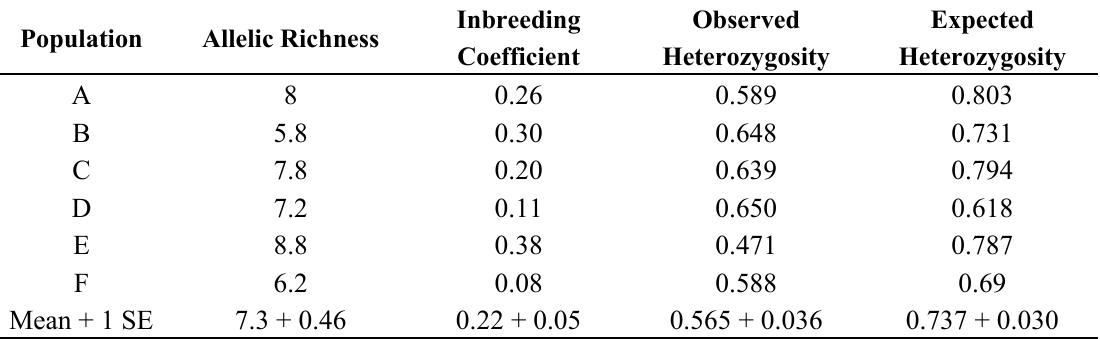
Table 1. Observed genetic variation of six Ambystoma maculatum populations in the greater Charlotte area of North Carolina, USA.